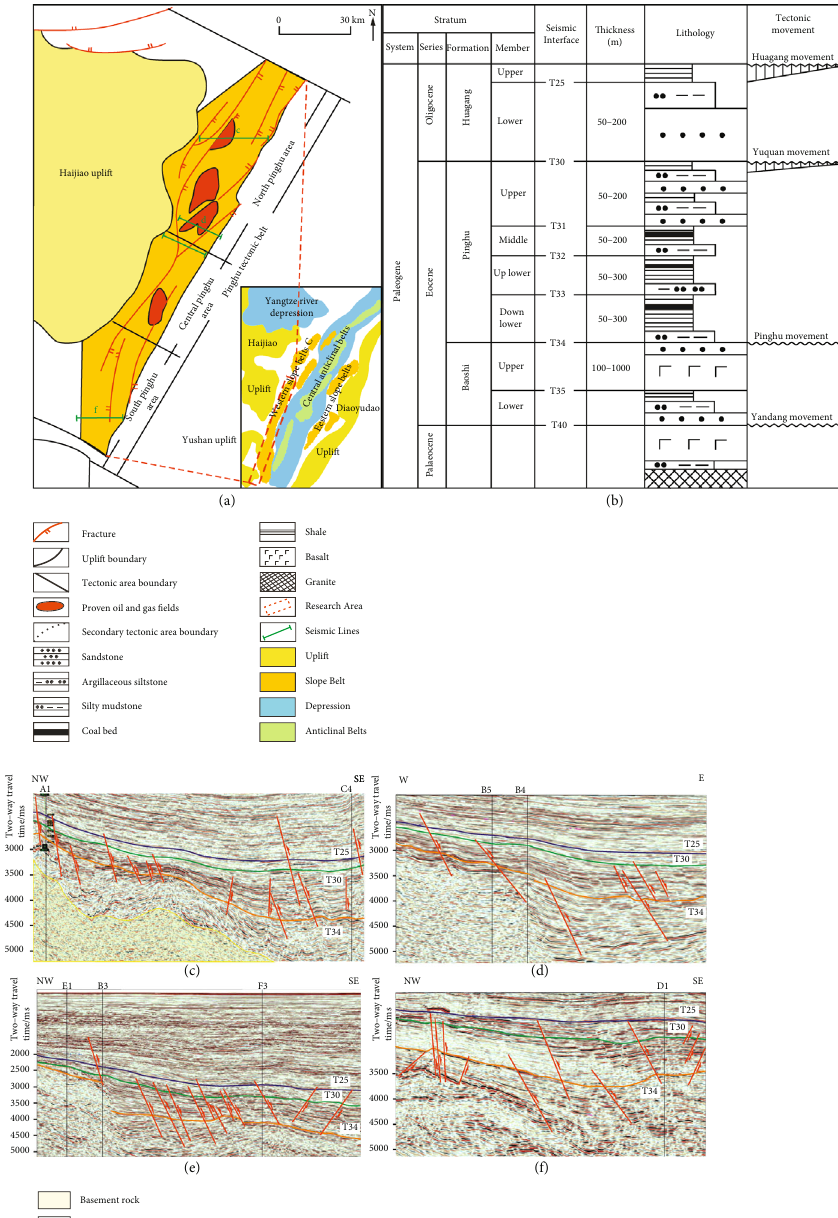
Figure 1: Tectonic development and stratigraphic columnar section of Pinghu Tectonic Belt in Xihu Sag (modi fi ed after Jiang et al. [17]): (a) study area and surrounding tectonic units; (b) stratigraphic age and lithology; (c) structural section and fault development in North Pinghu area; (d, e) structural section and fault development in Middle Pinghu area; (f) structural section and fault development in South Pinghu